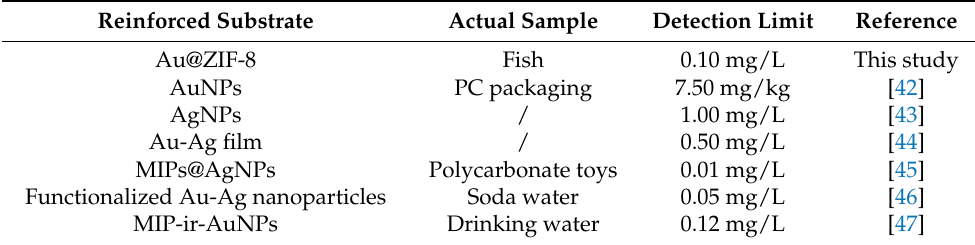
Table 4. Comparison of different SERS detection methods of